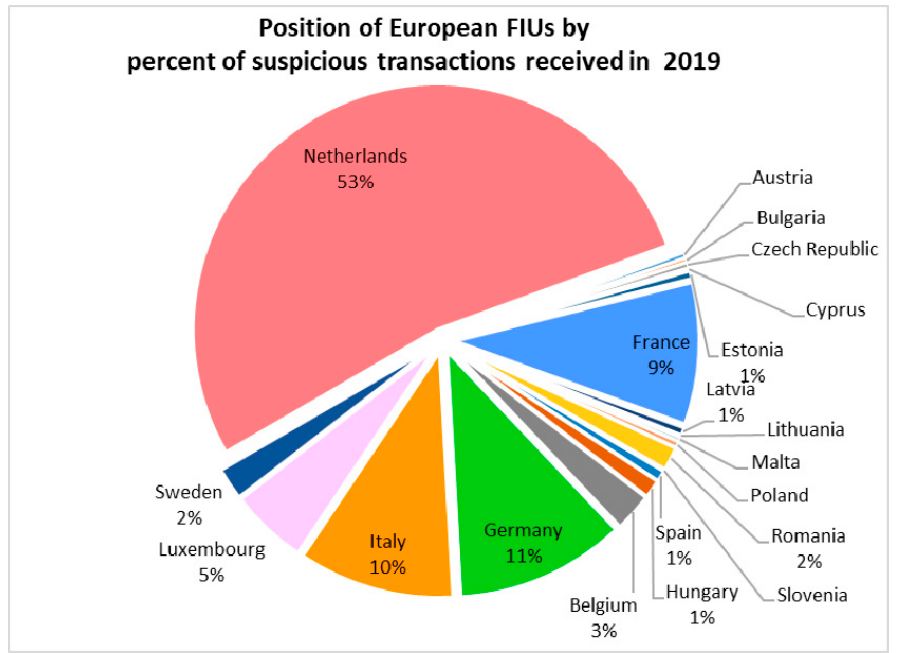
Figure 2. Position of European FIUs by percent of received suspicious transactions reports (STRs). Source: own processing.